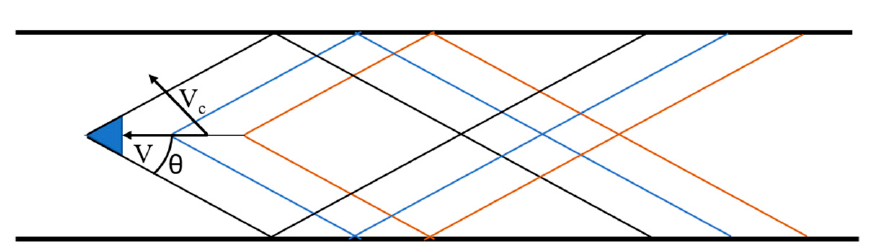
Figure 1. The wave pattern produced by the object traveling in a channel. Among them V is the object speed and V c is the propagation speed of the wave. Because the moving speed of the diamond wave is the same as that of the object, it looks stationary when viewed from the object. This is similar to when the tire expands to the flat plate. The external force corresponds to the object in Figure 1. When the tire speed is higher than the wave speed in the tire, the standing wave occurs. Thanks to the powerful processing power of the computer, a time-domain model was developed to study the standing wave in the